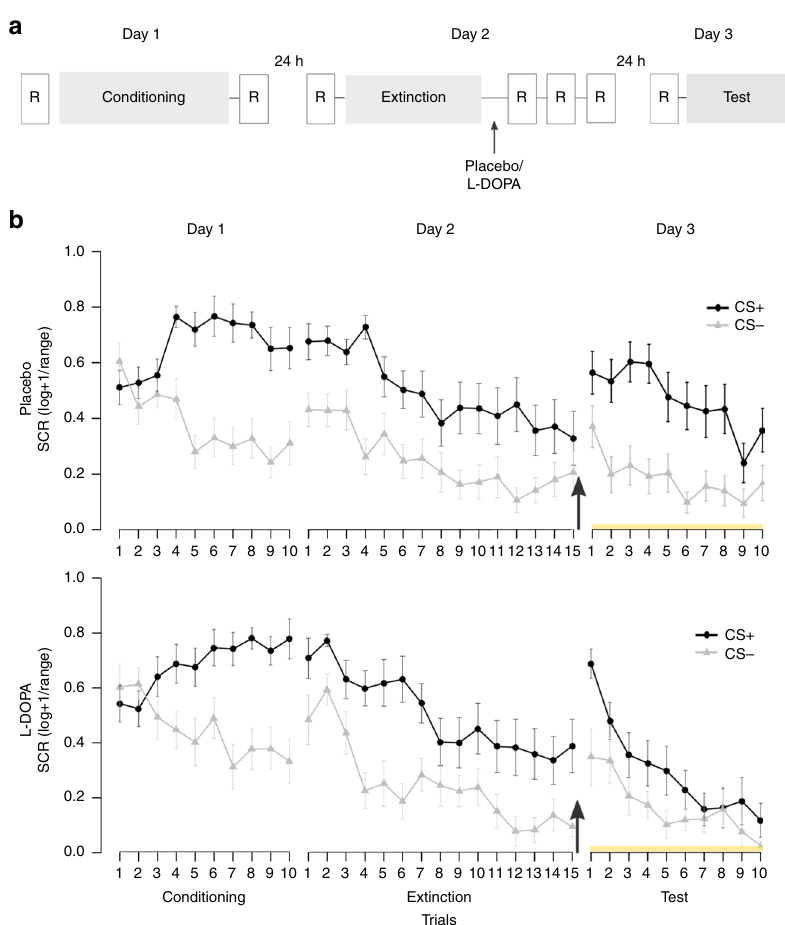
Fig. 1 Experimental design and skin conductance responses. a Participants underwent a 3-day fMRI study with fear conditioning on day 1, extinction and subsequent placebo or L -DOPA administration on day 2 and test on day 3. During fear conditioning one of two geometric symbols (CS + ) was reinforced with a painful electrical stimulation, while the other symbol (CS − ) was never reinforced. Postextinction placebo or L -DOPA administration was randomized and double-blinded (placebo: n = 20, L -DOPA n = 20, all male, for group characteristics, see Supplementary Table 1). Resting-state fMRI scans (R) were acquired before and after fear conditioning, before and 10, 45, and 90 min after extinction, and before test. b During all experimental phases, we assessed conditioned responses (CRs) as skin conductance responses (SCRs) to CS + and CS − . Upper panel depicts mean SCR to CS + and CS − for placebo-, lower panel for L -DOPA-treated participants. The groups differed signi fi cantly on mean SCRs across the test phase on day 3 (marked by yellow line) due to signi fi cantly smaller mean SCRs to the CS + in L -DOPA compared to placebo-treated participants. Note, that the group difference stemmed from signi fi cantly smaller CS + evoked SCRs averaged across the whole test phase, but the speed of re-extinction did not differ signi fi cantly between drug groups (control analysis with stimulus (CS + , CS − ) and trial (1 – 10) as within-, and group (placebo, L -DOPA) as between-subject factor: stimulus × group, F 1,33 = 6.58, P = 0.02, partial η 2 = 0.17; stimulus x trial x group, F 9,297 = 1.32, P = 0.23; n = 35). Data are presented as mean ± standard error of the mean